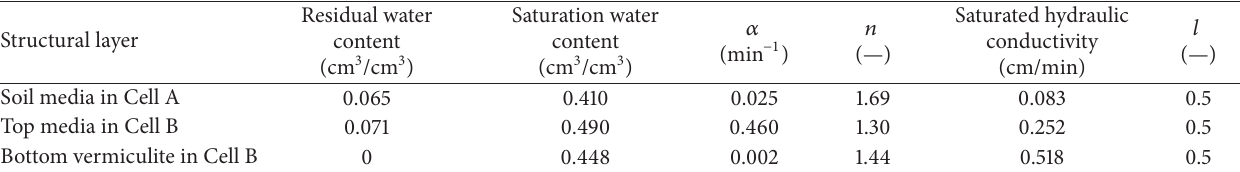
Table 2: The soil hydraulic parameters for the van Genuchten model in different structure